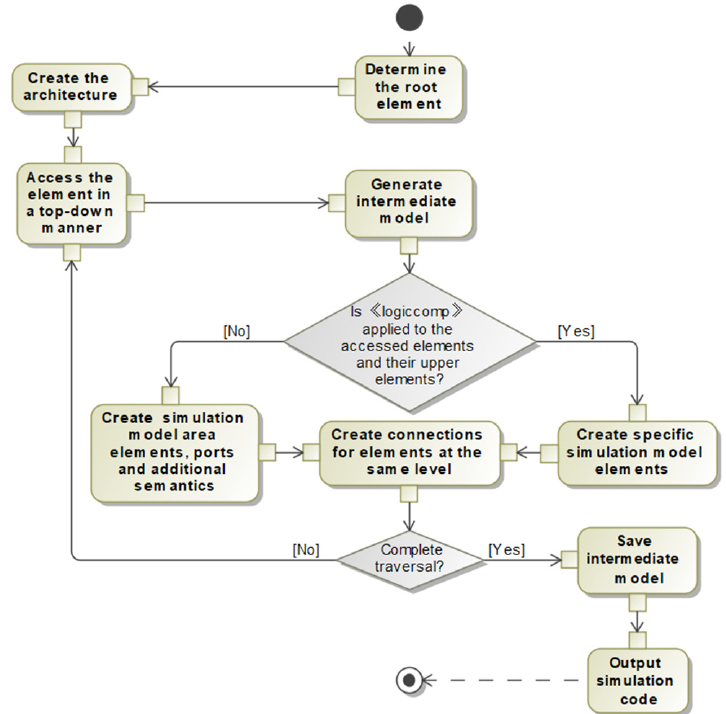
Figure 8. Model transformation process.